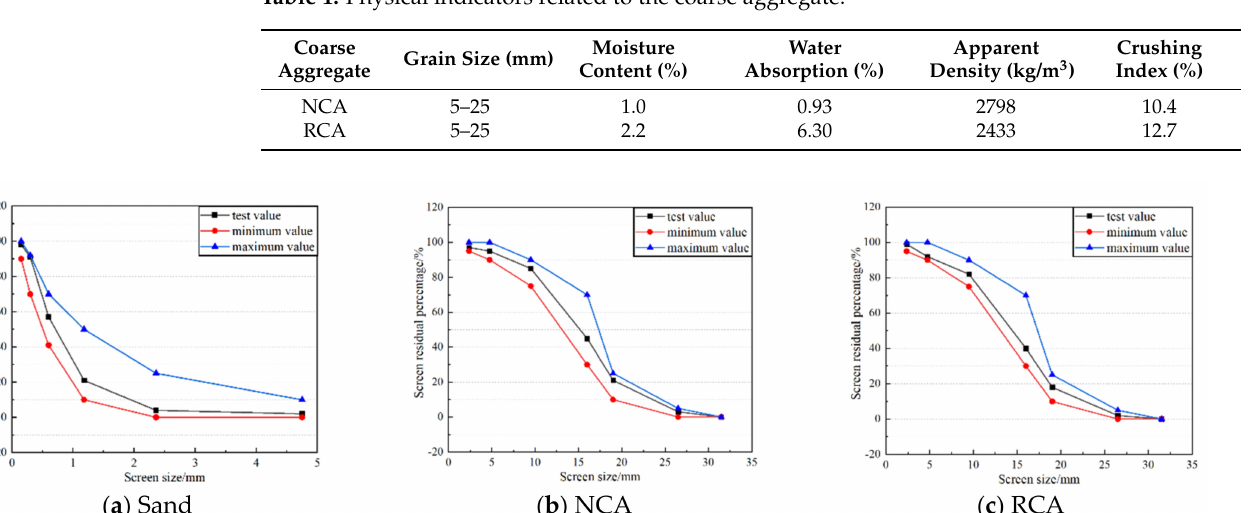
Table 1. Physical indicators related to the coarse aggregate.